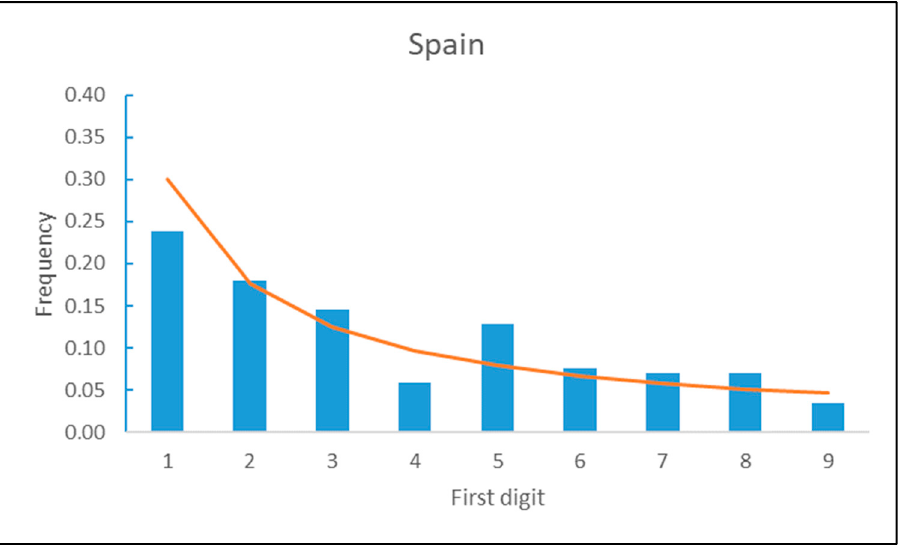
Figure 2. Frequency distribution of the first digit of the number of deaths per day by COVID in Spain.